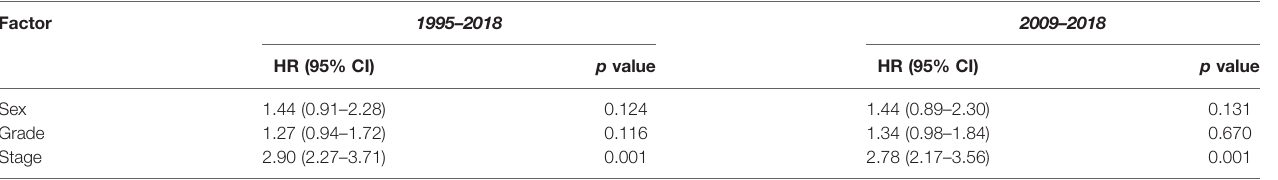
TABLE 4B | Hazard ratio (Multivariate – Cox regression